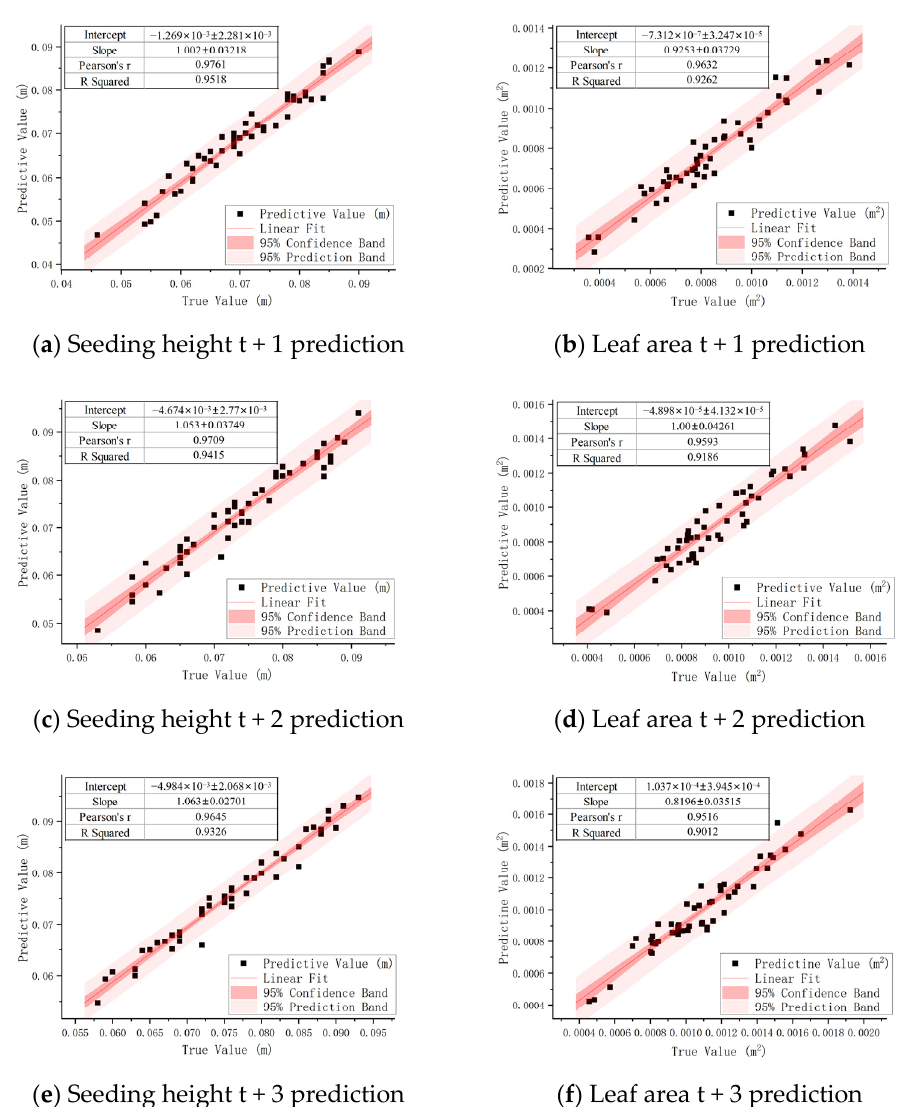
Figure 14. Regression analysis of LSTM time series prediction.